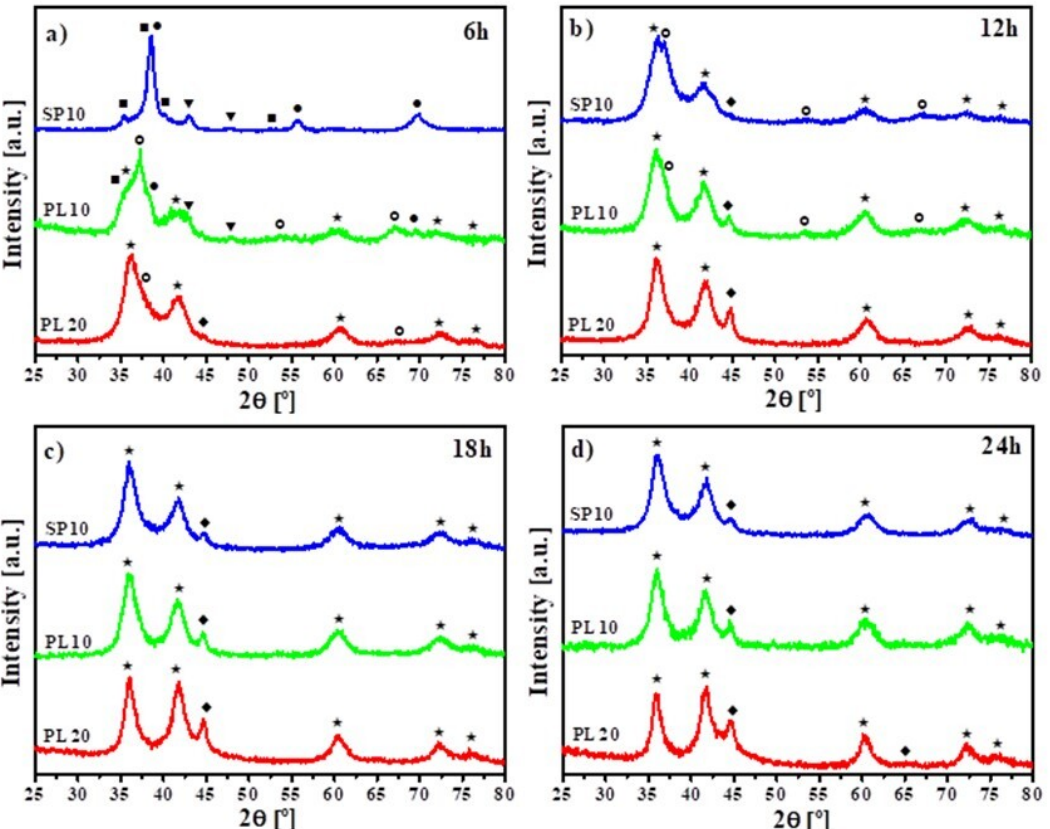
Figure 2. XRD patterns for the TiNb15Mn as-milled powdered mixtures, at 6 h ( a ), 12 h ( b ), 18 h ( c ) and 24 h ( d ). SP10: milled in the 8000D mixer/mill ® with a BPR equal to 10; PL10 and PL20: milled in the PM 400 planetary mill with a BPR equal to 10 and 20, respectively. ( ■ ) Ti (hcp, P63/mmc SGS); ( • ) Nb (bcc, Im3m SGS); ( ▼ ) Mn (bcc, I-43m SGS); ( ○ ) bcc-TiNbMn alloy (Im3m SGS); ( ★ ) fcc-TiNbMn alloy (Fm3m SGS); ( ♦ ) Fe (bcc, Im3m SGS).